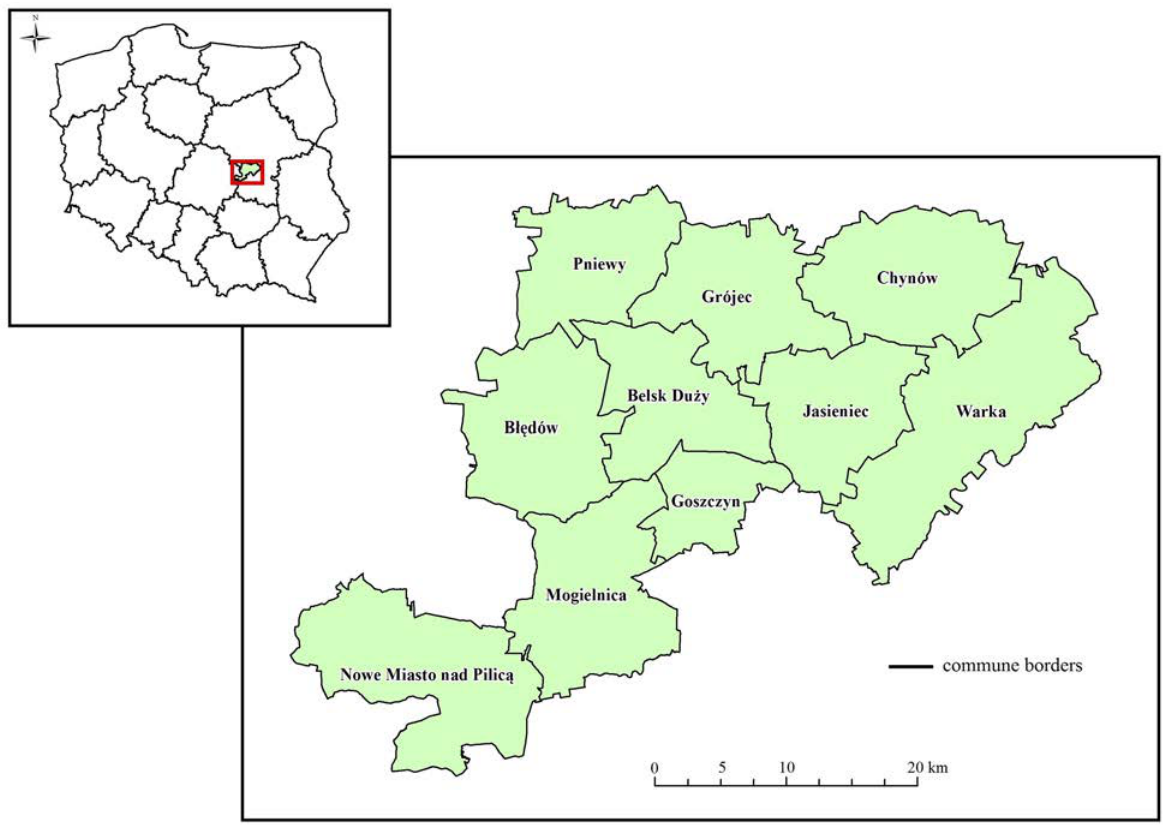
Fig. 1. The location and administrative division of Grójec